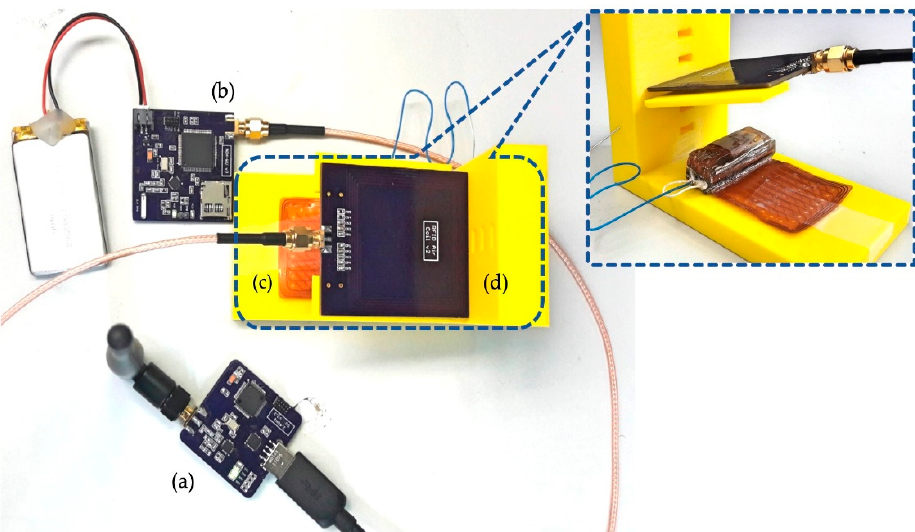
10 3.4. Graphical User Interface (GUI) An application-specific GUI is developed in LabVIEW, it allows the user to monitor the 64 channels GEA signals in real time and store them on computer for off-line analysis. Hence, 64 independent signal windows with modifiable time intervals are embedded in the GUI. Instantaneous rectified and battery voltages are also displayed in the GUI. Furthermore, the user can either continue receiving the data through the RF link or switch to micro SD memory card data logging mode, wirelessly. A snapshot of the developed GUI is shown in the results section. 4. Tests and Measurements Results To validate the high-resolution NFC signal acquisition and WPT systems, the setup shown in Figure 6 was implemented. The setup consists of the IU, the WU, the SU and a 3-D yellow-colored apparatus for the modification of the distances and the angles between the transmitter and receiver